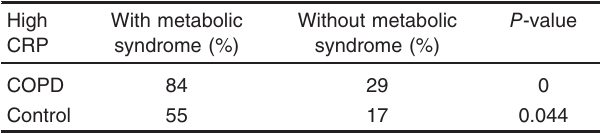
Table 6 Comparing high C-reactive protein levels in individuals with metabolic syndrome and those without metabolic syndrome with regard to chronic obstructive pulmonary disease and control